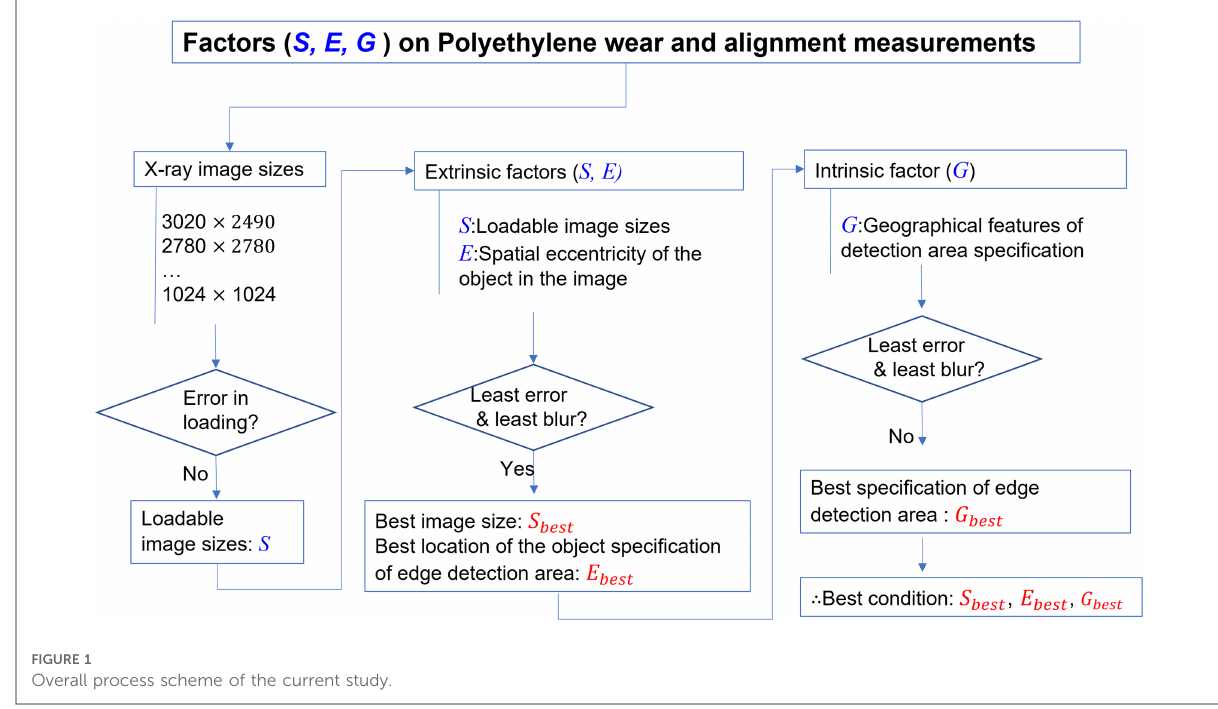
FIGURE 1 Overall process scheme of the current study.